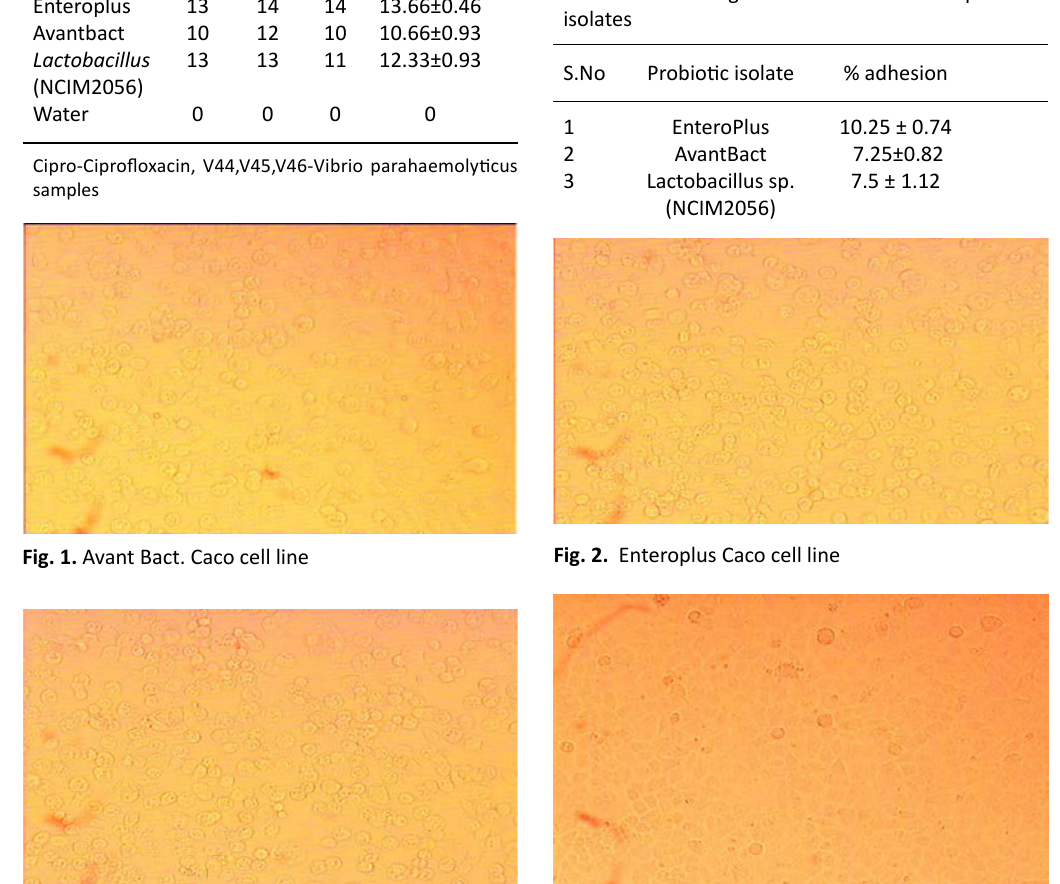
Table 3. Percentage adhesion of different probiotic